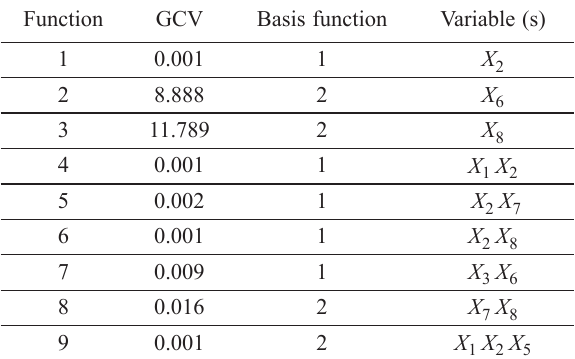
Table 3. ANOVA decomposition of the EMARS model